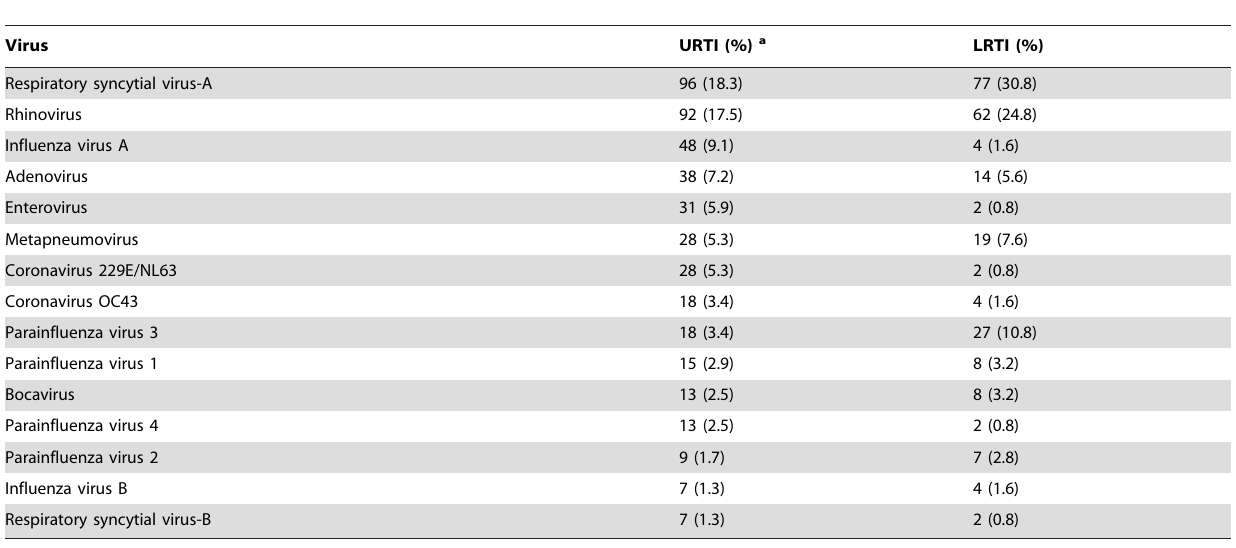
Table 1. Frequency of viral pathogens in children with URTI and